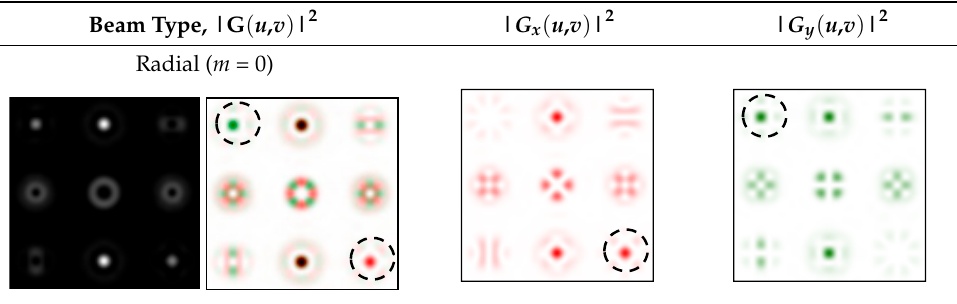
Table 6. Field distribution in the focal plane for cylindrically polarized beams of the second order ( p = 2) when using a filter with a superposition of optical vortices.